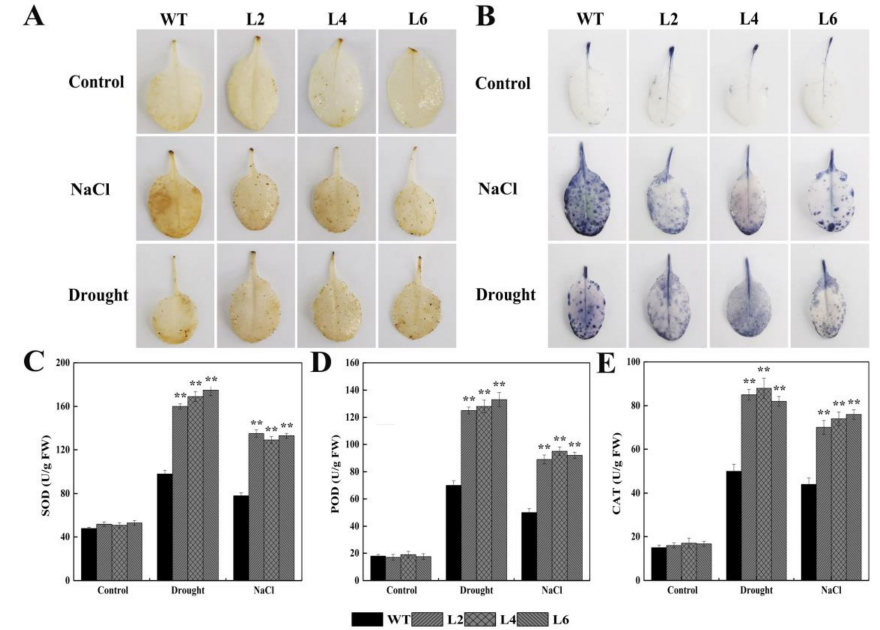
Figure 7. E ff ects of ectopic expression of FtbZIP5 on ROS accumulation and oxidative damage in Arabidopsis . The accumulation of H 2 O 2 and O 2- in the L2, L4, L6 and WT leaves were analyzed by DAB ( A ) and NBT ( B ) staining. ( C–E ) Determination of SOD, POD and CAT activity. The value is the mean ± SD of three biological replicates. ** Indicates significant di ff erences between the L2 / L4 / L6 plants and the WT plants. ** Indicates p <